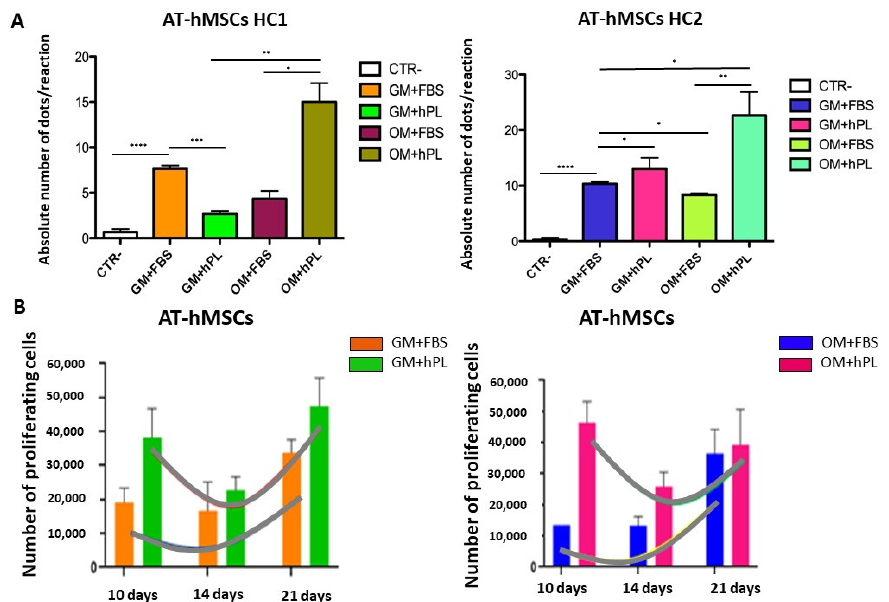
Figure 6. Osteogenic di ff erentiation of AT-hMSCs evaluated by OCN transcript absolute quantification. ( A ) The figure reports the absolute quantification of the OCN transcript level obtained by dPCR analysis of BM-hMSCs at 21 days. All conditions are reported: GM + FBS, GM + hPL, OM + FBS, OM + hPL, for HC1. GM + FBS, GM + hPL, OM + FBS, OM + hPL, for HC2. CTR- obtained by 2D culture of BM-hMSCs cultured with GM served as a negative control. Data are expressed as the absolute number of positive dots / reaction. Statistical significances calculated by t -tests with Welch’s correction (* p ≤ 0.05, ** p ≤ 0.01, *** p ≤ 0.001, **** p ≤ 0.0001); ( B ) BM-hMSCs proliferation trends. Proliferating BM-hMSCs cultured